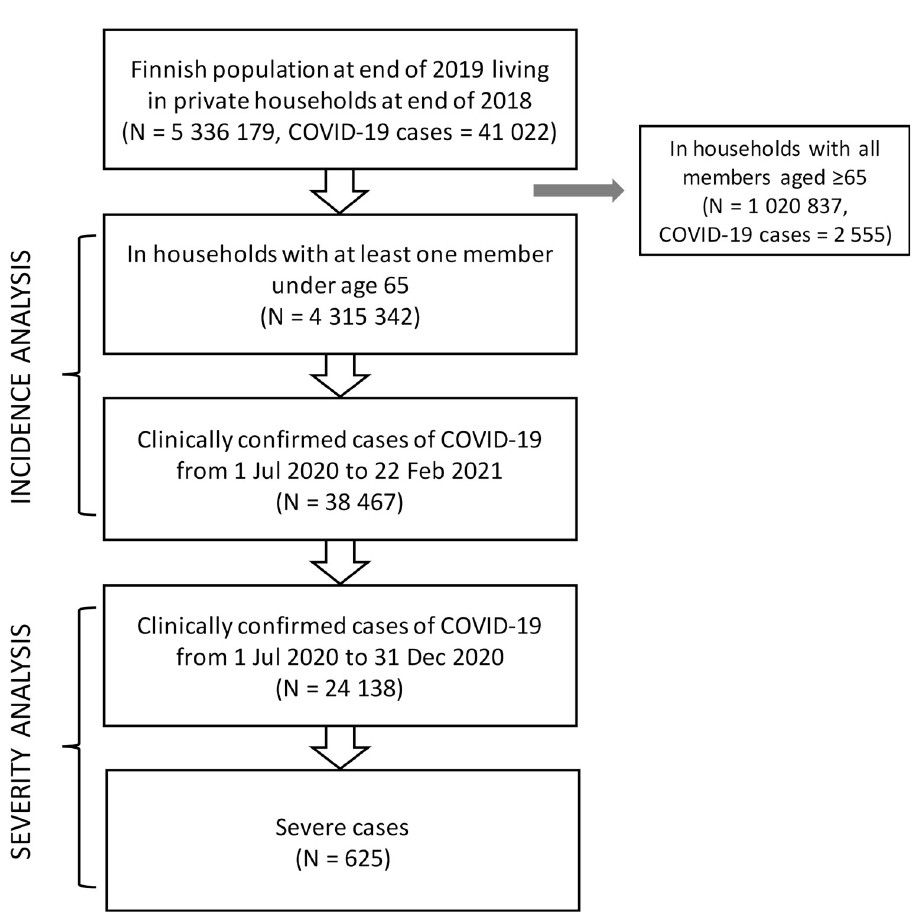
Fig 1. Data extraction flow chart. We obtained individual- and household-level data on demographic and socioeconomic characteristics from the population registers maintained by Statistics Finland, and measures of COVID-19 incidence and case severity from registers maintained by the Finnish Institute for Health and Welfare. The national health care registers cover both public and private sector health care providers. The individual-level data were linked using personal identification codes assigned to each resident and household-level data using a unique household identification code. Individuals were nested within households at the end of 2018 because more recent information was unavailable. All the covariates were measured at the most recent time point available in the registers (2017 to 2019).